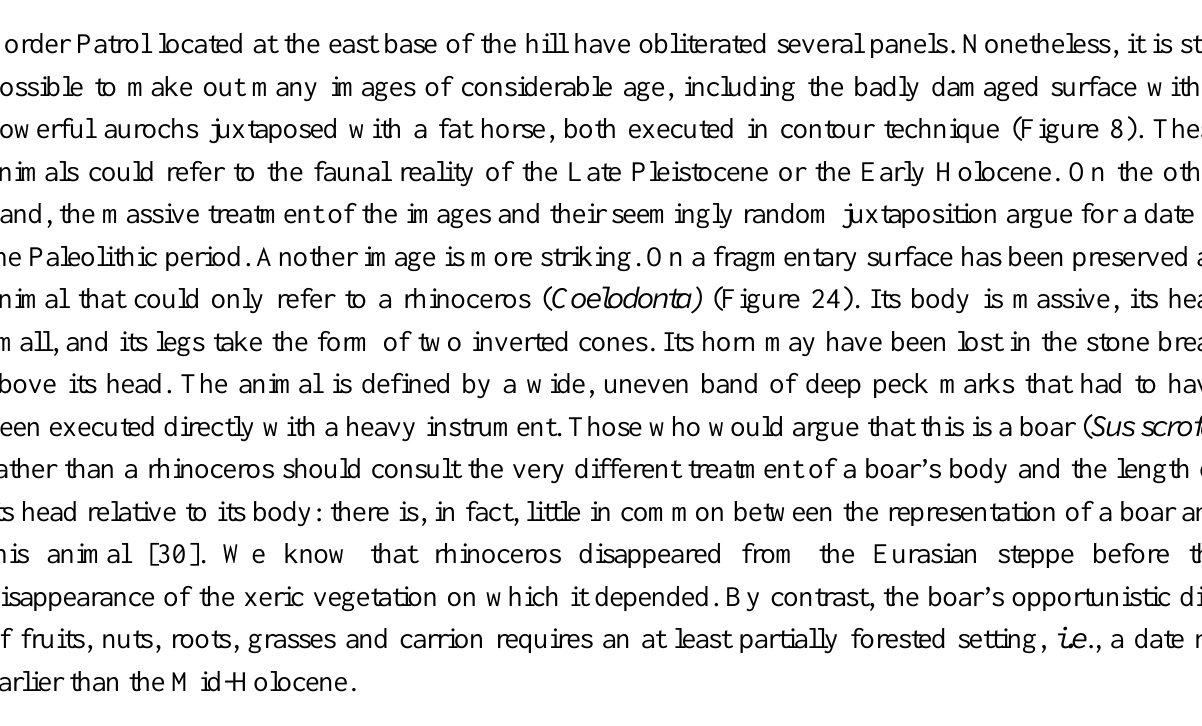
Figure 24. Rhinoceros. Paleolithic period. Aral Tolgoi. (http://oregondigital.org/u?/